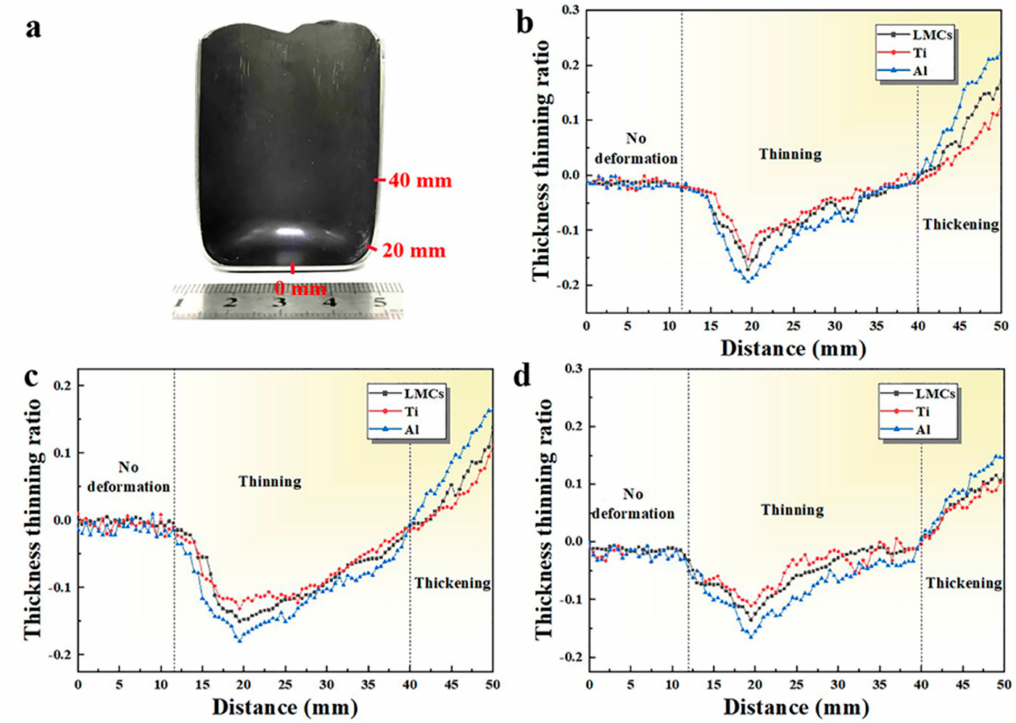
Figure 6. The thickness-thinning ratio of ( a ) the deep-drawing parts of Ti/Al multilayered composites with ( b ) three layers, ( c ) five layers, and ( d ) seven layers along the RD-ND